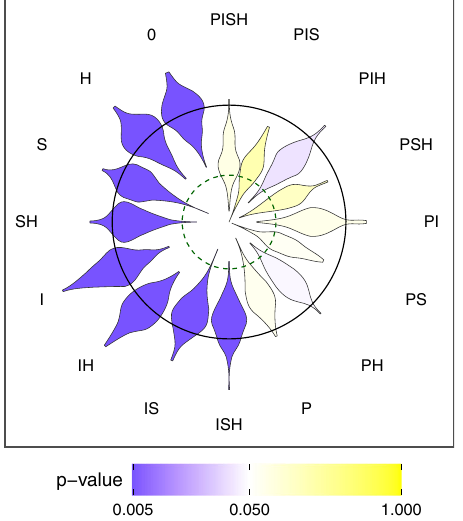
Fig. 5 Goodness-of- fi t for the 16 simulation scenarios testing which of the four mechanisms could account for the slope between the logit of the per-birth twinning probability and maternal total births shown in Fig. 2. The letters P, I, S & H are used to indicate which mechanisms were included in each simulation scenario. Mechanism P considers that a twinning event impacted parity progression. Mechanism I considers that a twinning event impacts the interval between that birth and the next one. Mechanism S considers that the reproductive schedule of a mother impacts both her twinning probability and her total number of births, creating an association between these two variables. Mechanism H considers that twinning propensity and intrinsic fertility are associated as a consequence of maternal heterogeneity. The scenario 0 does not include any of these mechanisms. The shape of each petal of the fl ower plot shows the distribution of slopes obtained for simulation replicates under each scenario ( n = 200 per scenario). The colour of each petal provides the result of a goodness-of- fi t test. Yellow petals correspond to simulation scenarios compatible with the observed slope ( p -value > 0.05) and purple petals correspond to scenarios incompatible with them ( p -value ≤ 0.05), with variation in the intensity of the colour re fl ecting the p -value as shown in the colour bar. The dashed green inner circular contour line represents the slope shown in Fig. 2. A simulation scenario that would consider the true mechanisms would therefore show a yellow petal whose centre was intersected by this circle. The black outer circular contour line corresponds to a null slope with negative slopes falling within the circle and positive slopes being